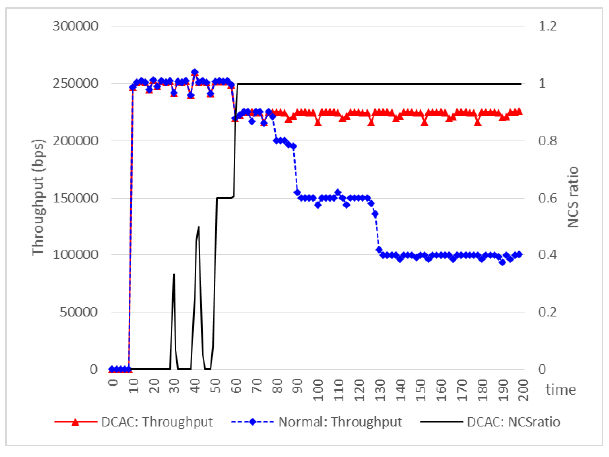
Figure 2. Throughput of DCAC and normal DESYNC according to the NCS